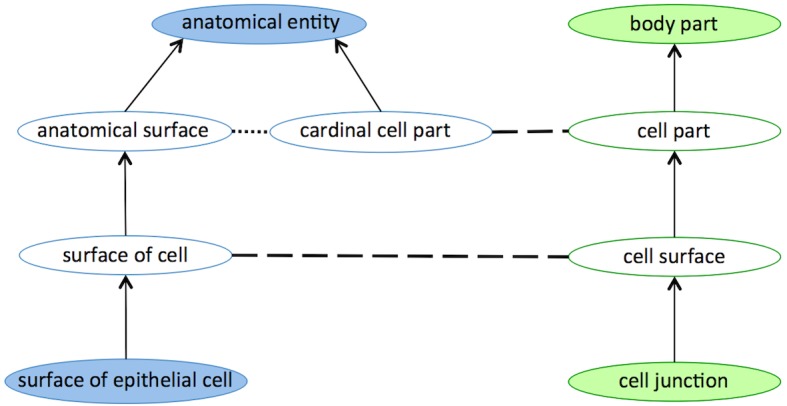
Example of two mappings taken from the UMLS-based Alignment between FMA and NCI ontologies, illustrated as blue and green respectively.Circles represent classes, arrows represent subclass relationships between classes, dashed lines represent mappings between classes, and dotted lines represent disjointness restrictions between classes. The circles filled in white represent the classes in the core fragments of the ontologies given the alignment.